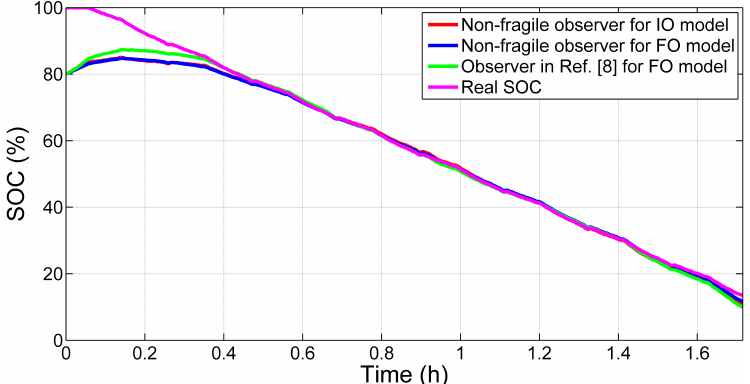
Figure 13. SOC estimation profiles for HWFET.